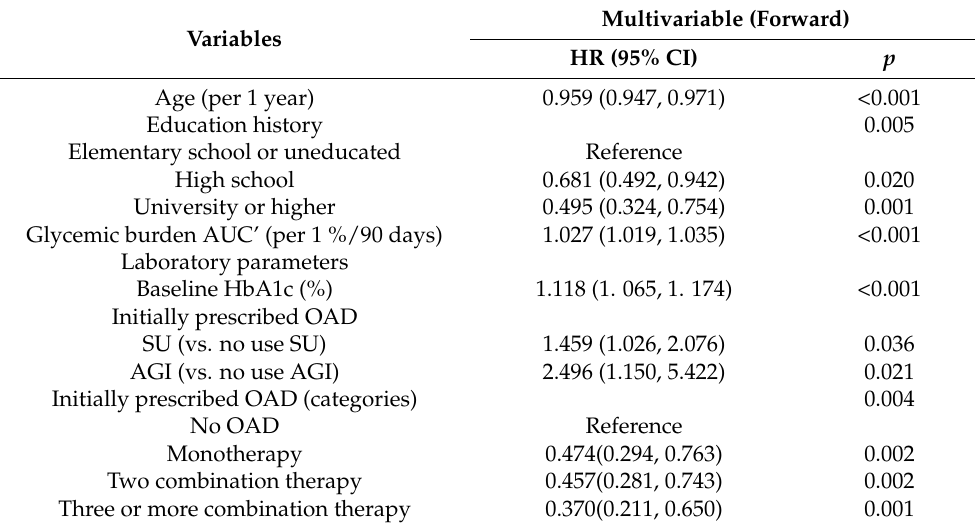
Table 2. Determinants of glycemic burden and other clinical characteristics with treatment failure in all study participants ( n = 1048) using multivariable forward Cox proportional hazards analysis. Variables